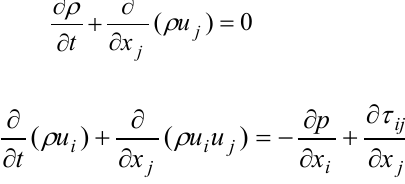
Figure 1. Schematic of pintle nozzle.